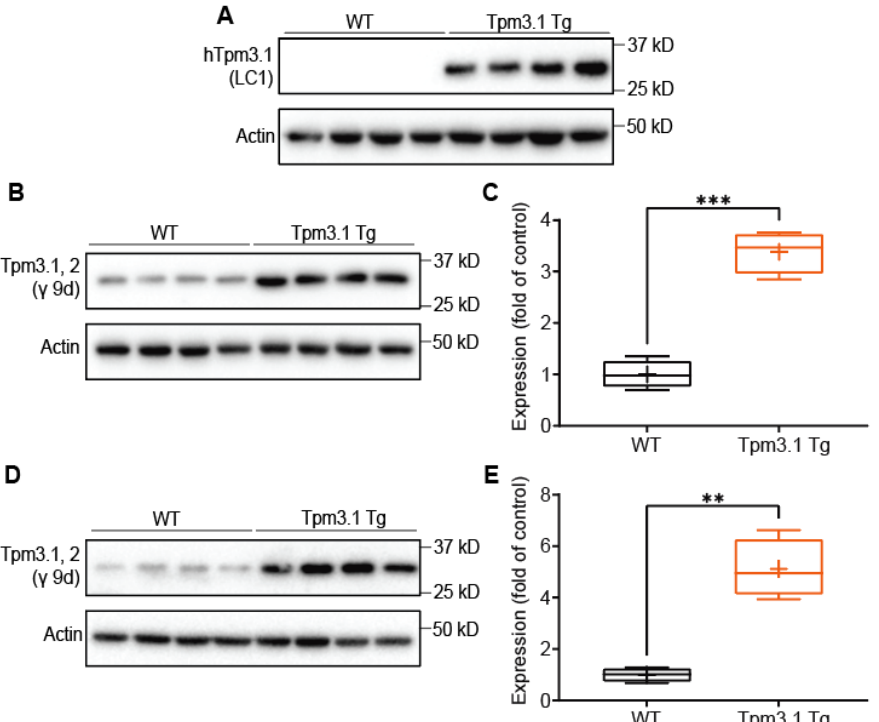
Figure 1. Expression of Tpm3.1 in brain homogenate and PSD of Tpm3.1 Tg mice, compared to WT mice. ( A ) Western blot using LC1 antibody shows expression of hTpm3.1 in transgenic mice and absence in WT mice. ( B , C ) γ 9d antibody for Tpm3.1 shows enrichment of Tpm3.1/2 in transgenic mice compared to WT in whole brain homogenate and ( D , E ) postsynaptic fraction. n = 4 mice per group. WT values are shown in black, Tpm3.1 Tg values shown in orange. ** indicates p < 0.01, *** indicates p < 0.001.